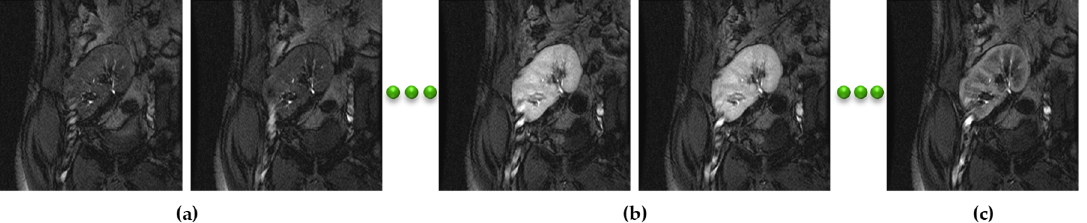
Figure 1. An example of DCE-MRIs of one subject depicts the contrast changes from the pre-contrast phase ( a ), moving on to the post-contrast phase ( b ), and ending with the late-contrast phase ( c ) during the perfusion of the contrast agent into the blood stream.